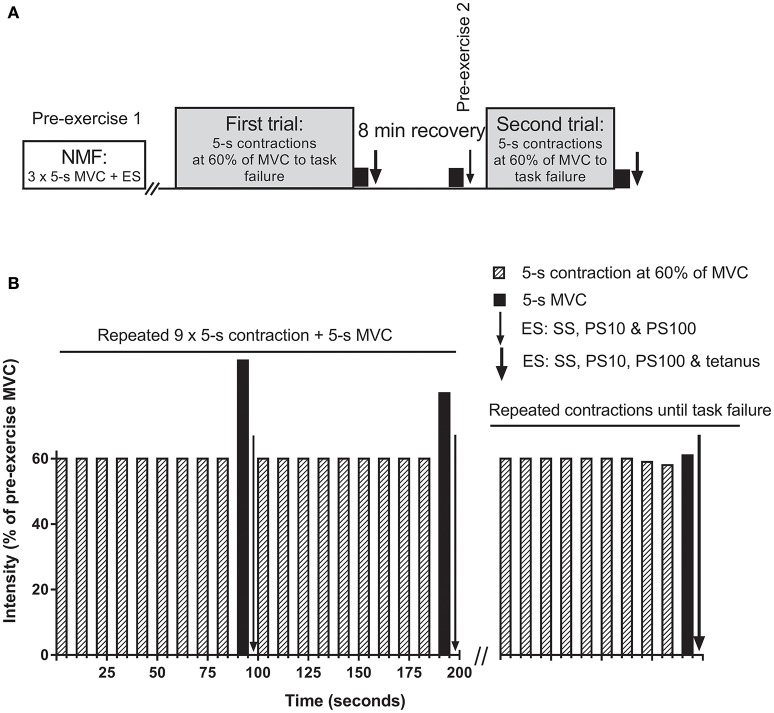
Overview of the protocol (A) and detailed description of the trials (B). (A) first and second trials were separated by a break of 8 min including the neuromuscular function measurements (NMF). NMF, i.e., a maximal voluntary contraction (MVC) followed within 2 s by electrical stimulation (ES), was assessed three times prior to the first trial (pre-exercise 1), after each set during the trials, at task failure, as well as 1 min before the second trial (pre-exercise 2). (B) trials consisted of consecutive sets of 10 × 5-s isometric contractions followed by 5-s rest between contractions. The first nine contractions were performed at a target force at 60% of pre-exercise MVC, while the 10th contraction in each set was a MVC. ES was applied in the 5-s break before the next set of contractions began. Sets of contractions were repeated until task failure. SS, single stimulus; PS10, paired stimuli at 10 Hz; PS100, paired stimuli at 100 Hz; tetanus, 50 stimuli at 100 Hz.